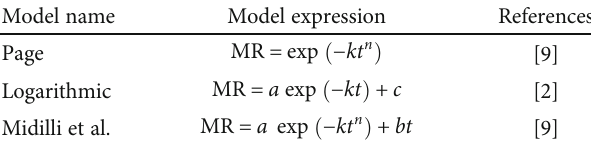
Table 1: Mathematical models that were applied to drying